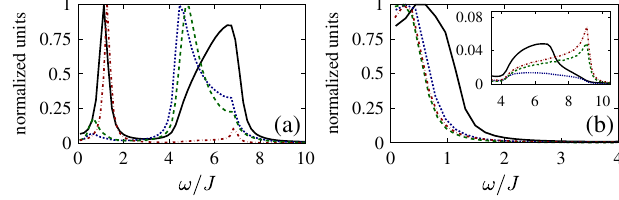
FIG. 22. Comparison between the RPA susceptibilities, angle- resolved spectrum, and the spectrum collected by a lens over a range of scattering angles. The ratio between the wave number of the probe light to the effective wave number of the optical lattice light is κ ¼ 1 . 5 [Eq. (59)] and U ¼ 5 J . Each line shown has been normalized to its maximum value for comparison. We show s L ð ω Þ [solid (black) line], s L ð ω Þ [dotted (blue) line], S ð Δ k ; ω Þ 0 . 1 0 . 5 [dashed (green) line], and χ ð Δ k ; Δ k ; ω Þ [dot-dashed (red) line]. Panel (a) shows the configuration with a lens in the forward direction [Fig. 16(b)]. The angle-resolved quantities, the spec- trum S ð Δ k ; ω Þ , and total susceptibility χ ð Δ k ; Δ k ; ω Þ are com- puted at a wave vector close to the axis of the lens ( θ ∼ 0 , ϕ ∼ 0 ). Panel (b) shows the case for a lens in the perpendicular direction [Fig. 16(c)]. S ð Δ k ; ω Þ and χ ð Δ k ; Δ k ; ω Þ are computed at a wave vector Δ k close to the axis of the lens at ( θ ∼ π = 2 , ϕ ∼ π = 4 ). Panel (b) shows the collective mode at low energies, and the inset shows the single-particle excitations at energies above the